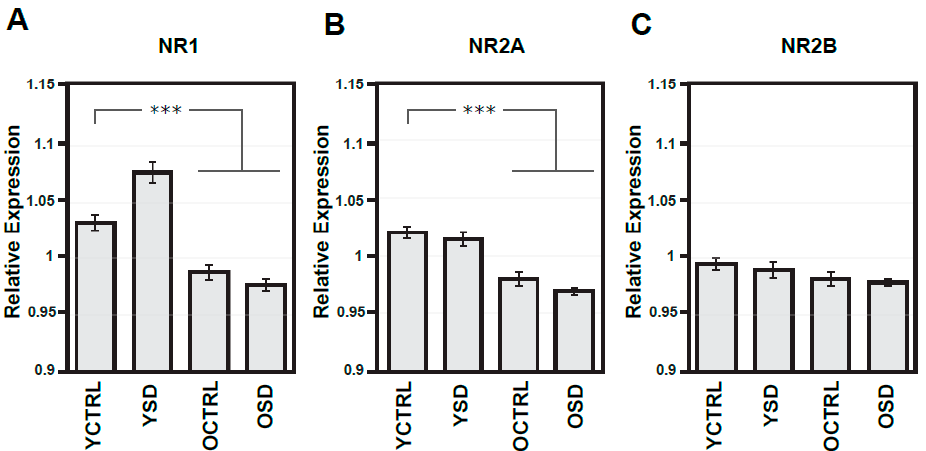
Figure 6. Expressions of NMDA receptor subunits in the frontal cortex from both hemispheres in young adult and old rats exposed to chronic sleep deprivation. Summary histograms illustrating the expressional changes in NR1 ( A ), NR2A ( B ) and NR2B ( C ) subunits. The optical density of samples of respective NMDA subunit bands was related to that of α -tubulin, results are presented as means ± SEM. Statistical significance (Student’s t -test) was calculated with respect to young adult controls (*** p < 0.001). SD—sleep deprivation, YCTRL—young adult controls ( n = 12), YSD—young adult rats exposed to chronic SD ( n = 12), OCTRL—old controls ( n = 12), OSD—old rats exposed to chronic SD ( n = 12).